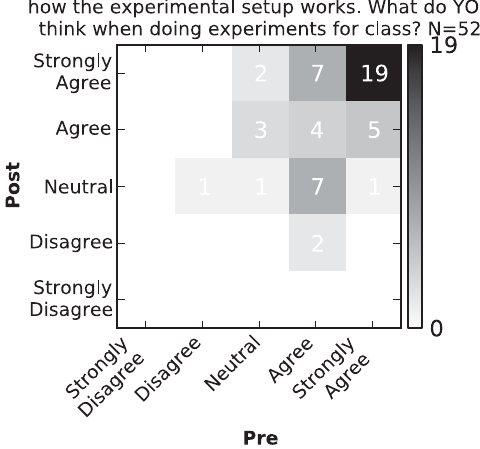
FIG. 3. The pre and post response data for a single statement summarized as a 2D histogram. The number inside each box corresponds to the number of students with each (pre, post)